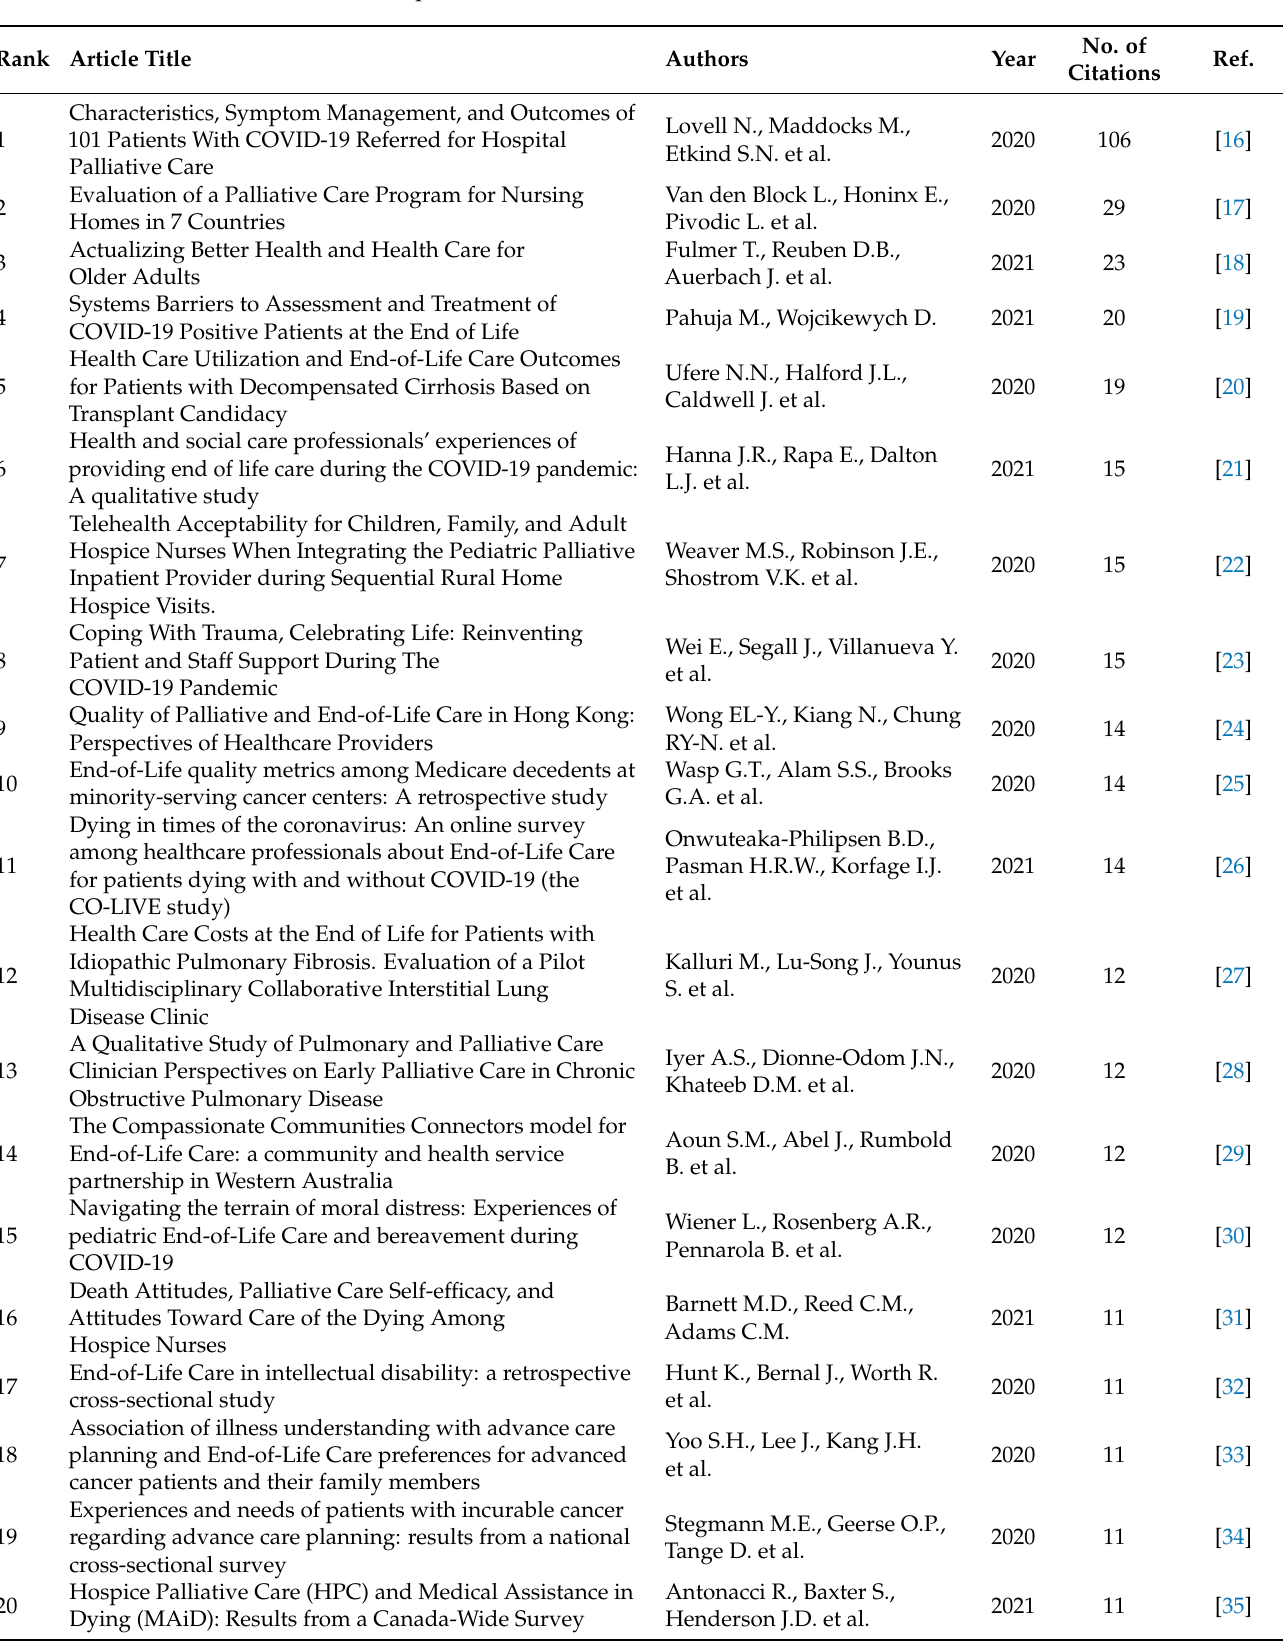
Table 3. Top 20 articles with the most